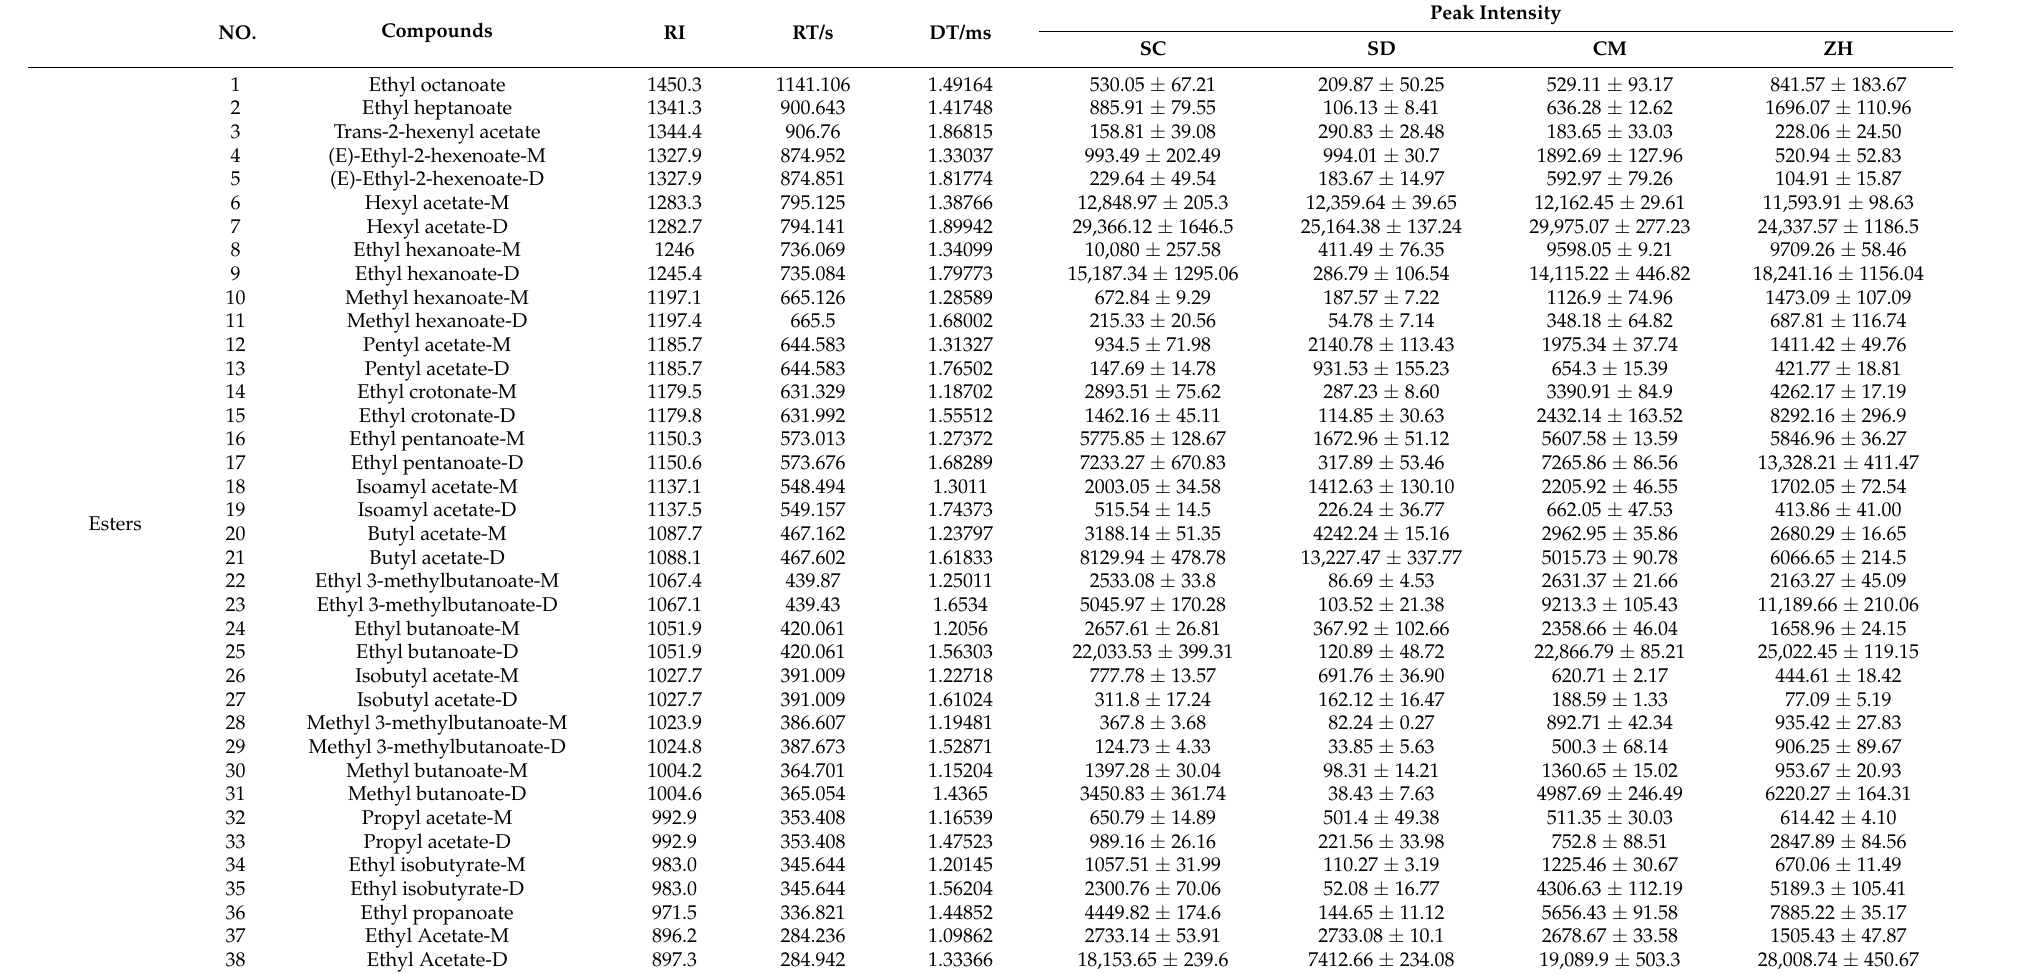
Table 3. Volatile compounds tested from Cuiguan pear of different regions using